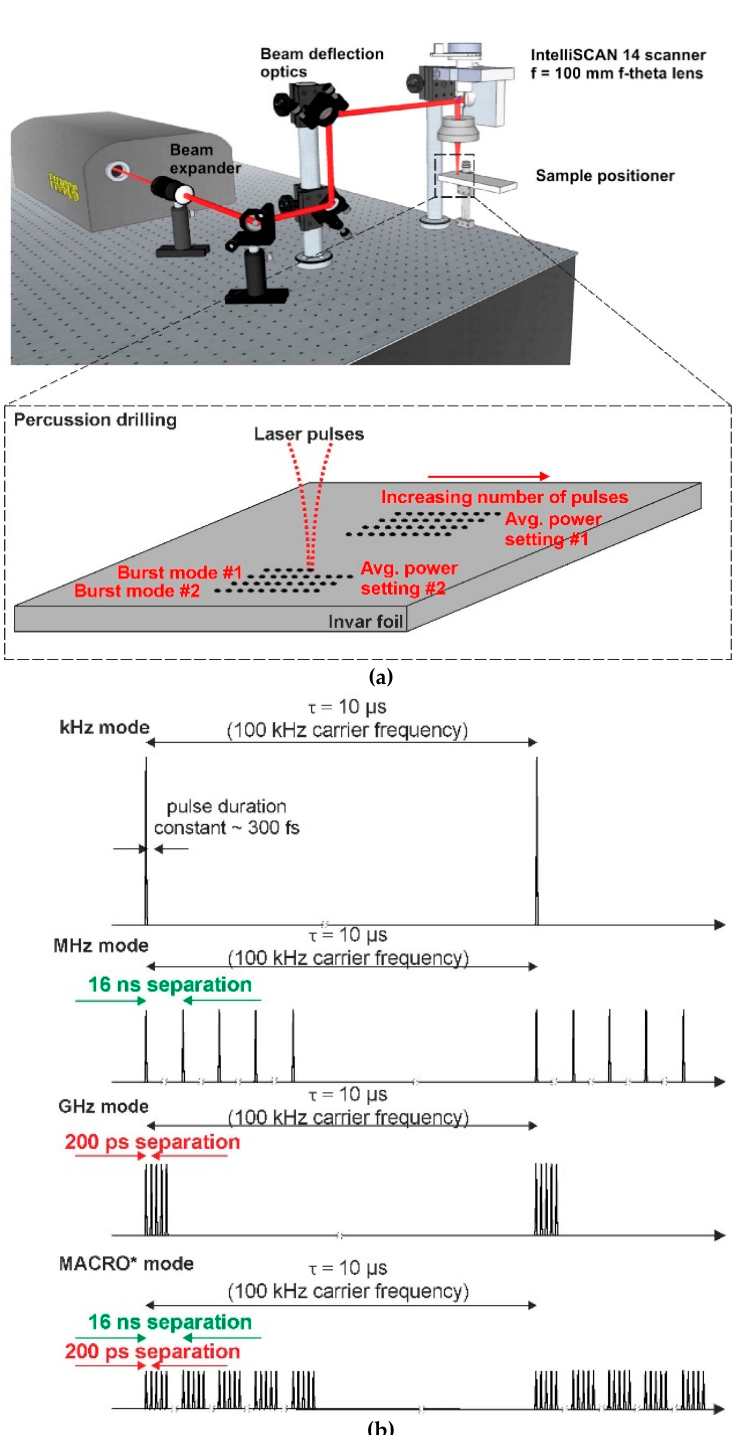
Figure 1. ( a ) experimental setup for Invar foil percussion drilling. The bottom part shows the fabrication algorithm used. ( b ) illustration of the burst modes generated by the laser. The 16 ns temporal separation equates to a MHz, whereas the 200 ps to a GHz repetition rate. The MACRO mode is a combination of the MHz and GHz modes and produces a number of pulses temporally separated by 200 ps, which are grouped by identical trains spaced by 16 ns. The integrated energy per cycle is the same for all the di ff erent burst